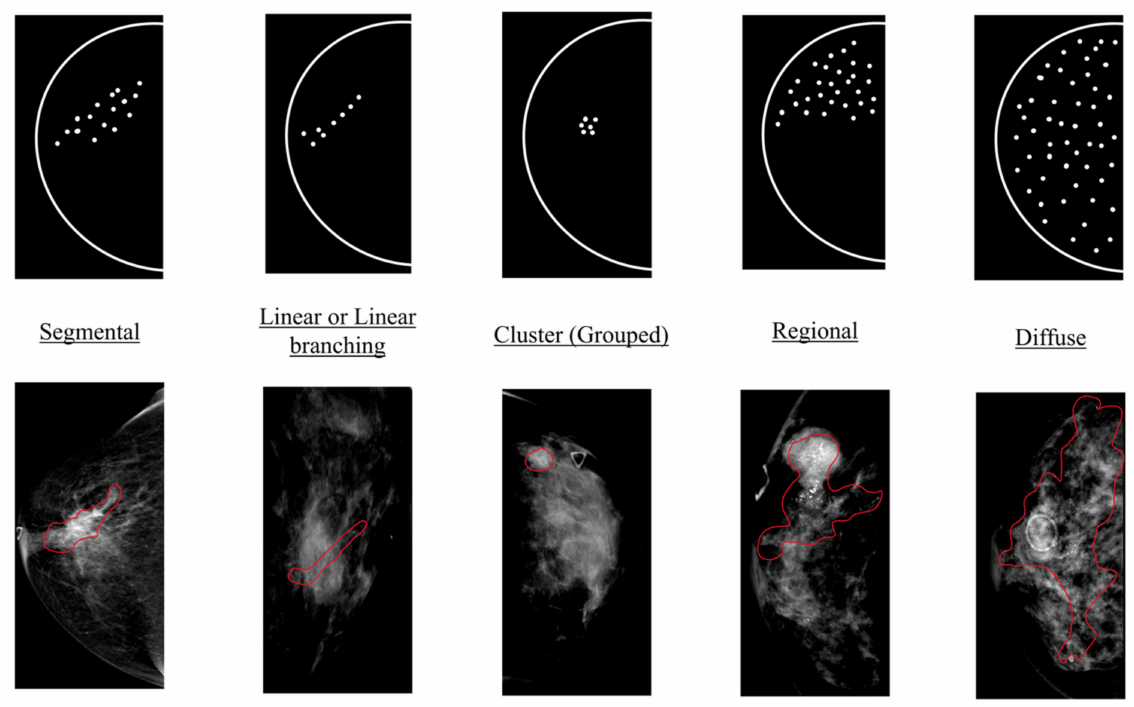
Figure 1. Examples of calcification distribution descriptors. For each distribution descriptor, one illustration is shown on the top and one example from the study dataset is shown at the bottom. Illustrations are adapted according to BI-RADS 5th Edition [9]. Calcification patterns are annotated and marked by red contours in